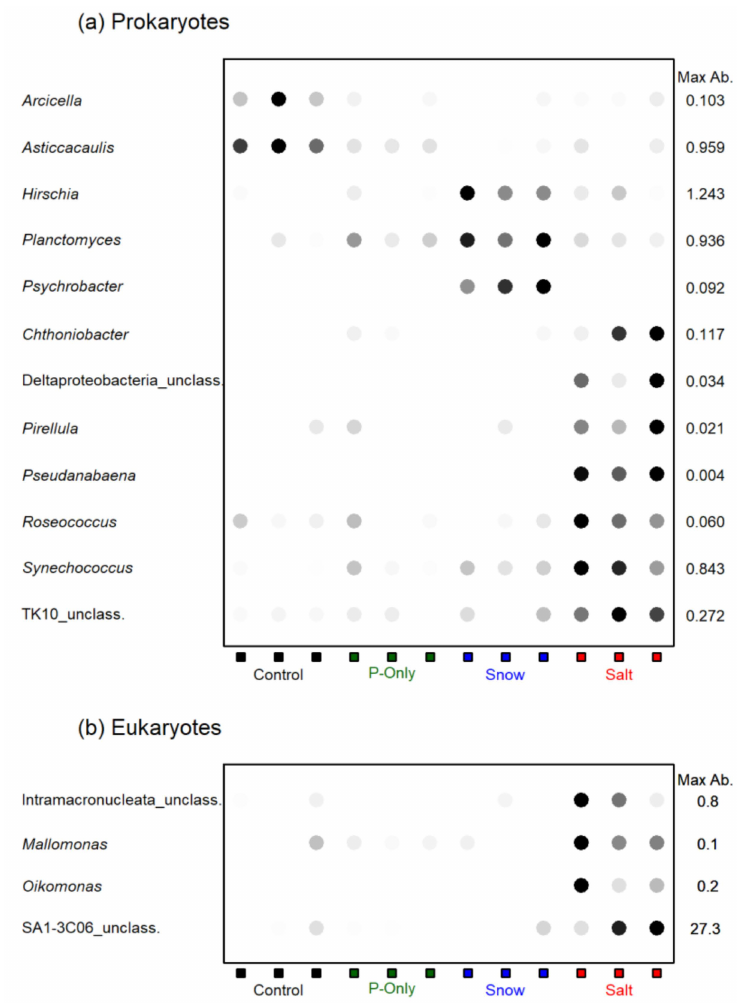
Figure 3. Taxa that increased in response to the different treatments. Max. ab.: highest abundance, expressed as a percentage of the total number of reads. The shading scale for the dots goes from 0 (white) to Max Ab. (black). ( a ) prokaryotes; ( b )